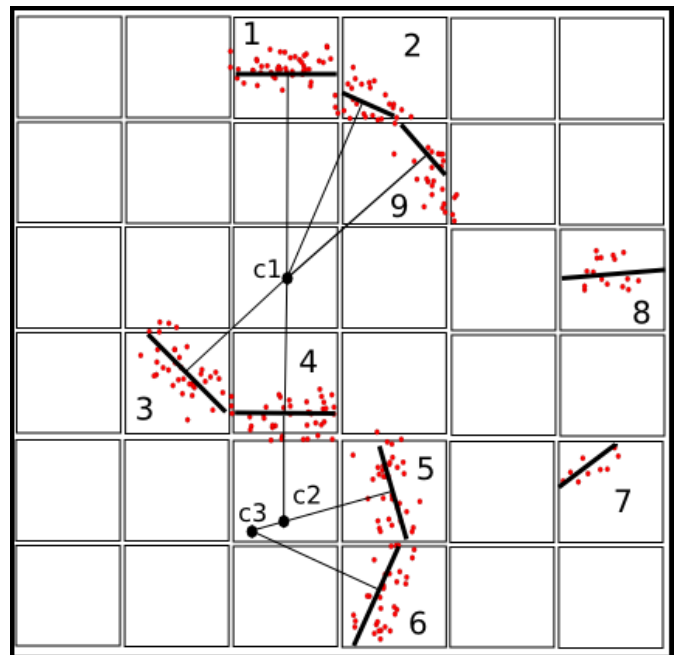
Figure 2. Two-dimensional view of the three-dimensional grid. Cells 1–9 contain laser data points. In each grid cell, a plane (thick line) is derived from the laser data points using the eigenvectors and eigenvalues. The centers c1–c3 are derived from the normals (thin lines) of two connected planes. The plane in Cell 4 is connected to two centers. Planes with several possible centers are connected to the center with the highest weight. The planes in Cells 7 and 8 are not connected to any neighbor and, therefore, not connected to possible tree stem